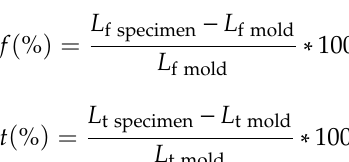
Figure 14. SEM micrographs for PP-HDPE-CCF 10 (a,b,c) and PP-HDPE-CCF 30 (d,e).